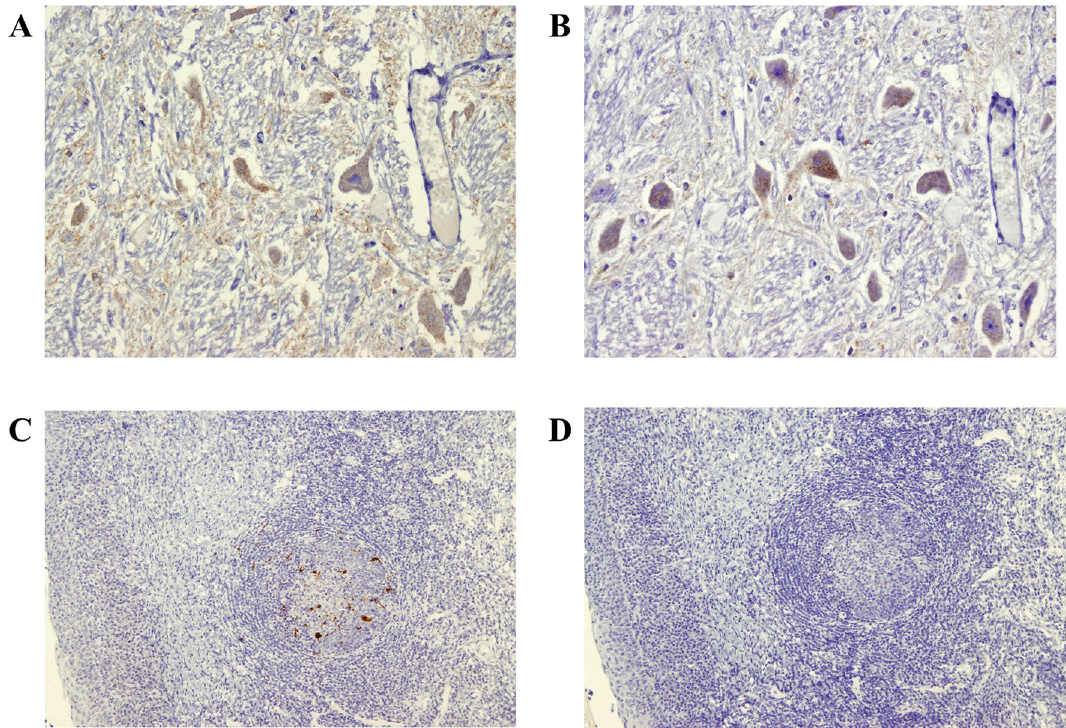
Figure 4. Discriminatory immunohistochemistry of sheep brain and tonsil from a mixed infection sheep with scrapie signal in brain and BSE in periphery. Sections of medulla [lateral cuneate nucleus; ( A , B ); × 20] and tonsil [( C , D ); × 10) from VRQ/ARQ sheep Z115 were stained with antibody R145 in ( A ) and ( C ); or 12B2 in ( B ) and ( D ). Results show labelling of intraneuronal PrP d with both R145 and 12B2 in brain ( A , B ), whereas in tonsil ( C , D ) labelling of tingible body macrophages within germinal centre was seen only with R145, the 12B2 reaction being